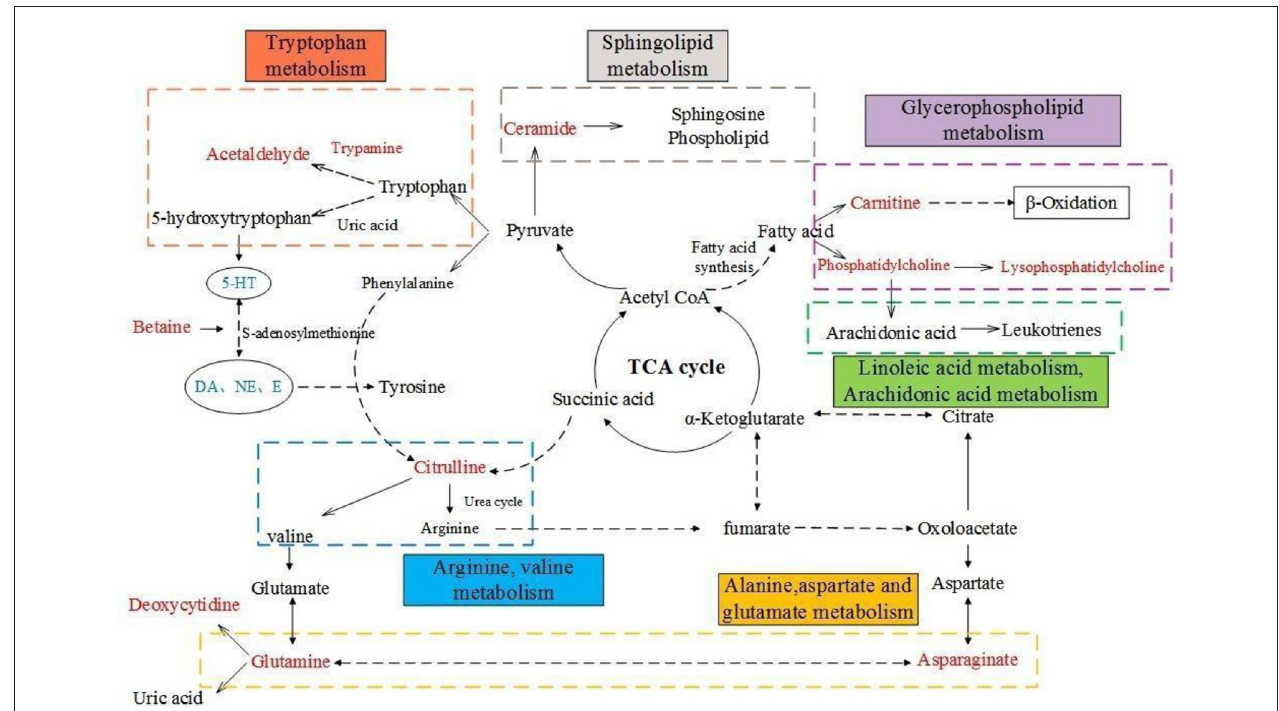
FIGURE 11 | Overall metabolic pathway map of model rats. Red characters are metabolites for screening, blue are pharmacodynamic index; Solid line is one-step reaction, dotted line is multi-step reaction.